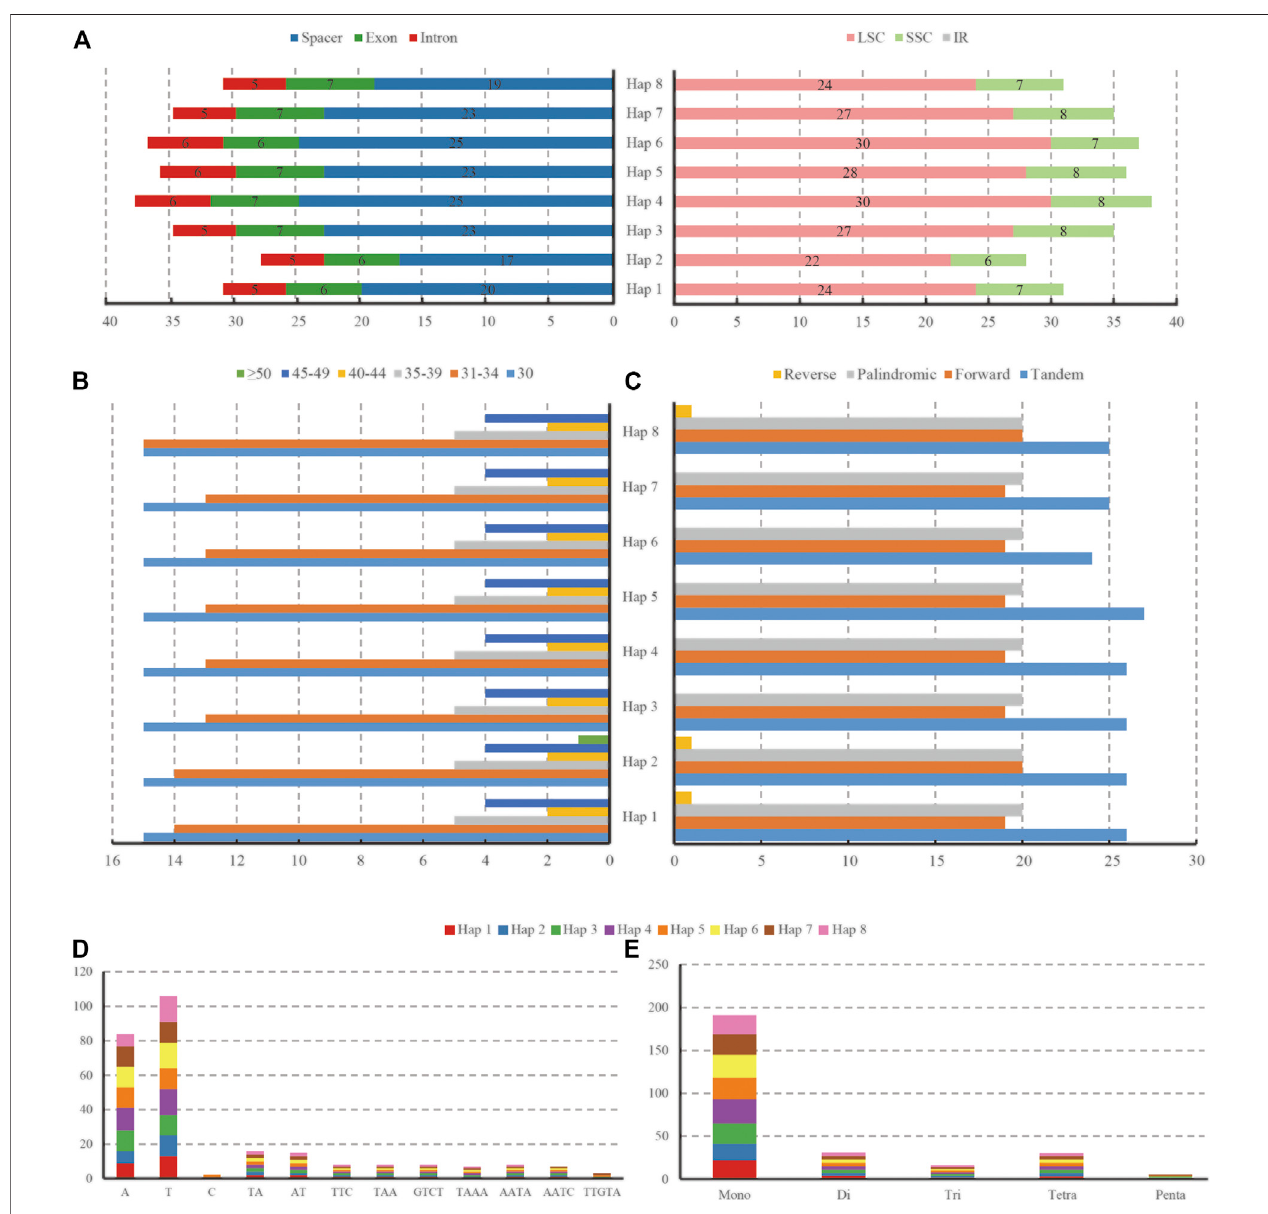
FIGURE6| Thetypeanddistribution ofSSRsintheeighthaplotypesof L.cardiaca chloroplastgenomes. (A) NumberofSSRoccurrenceindifferentregions(LSC, SSC, IR and spacer, exon, intron). (B) Number of repeat sequences by length (C) Number of four repeat types (D) Number of identi fi ed SSR motifs in different repeat class types. (E) Number of SSR repeat types detected by